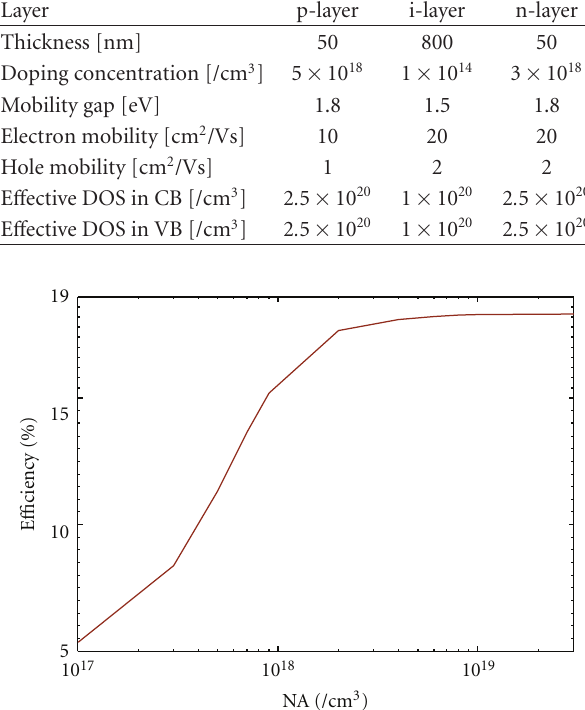
Figure 3: The a-SiGe:H solar cell e ffi ciency as a function of concen- tration of acceptor in